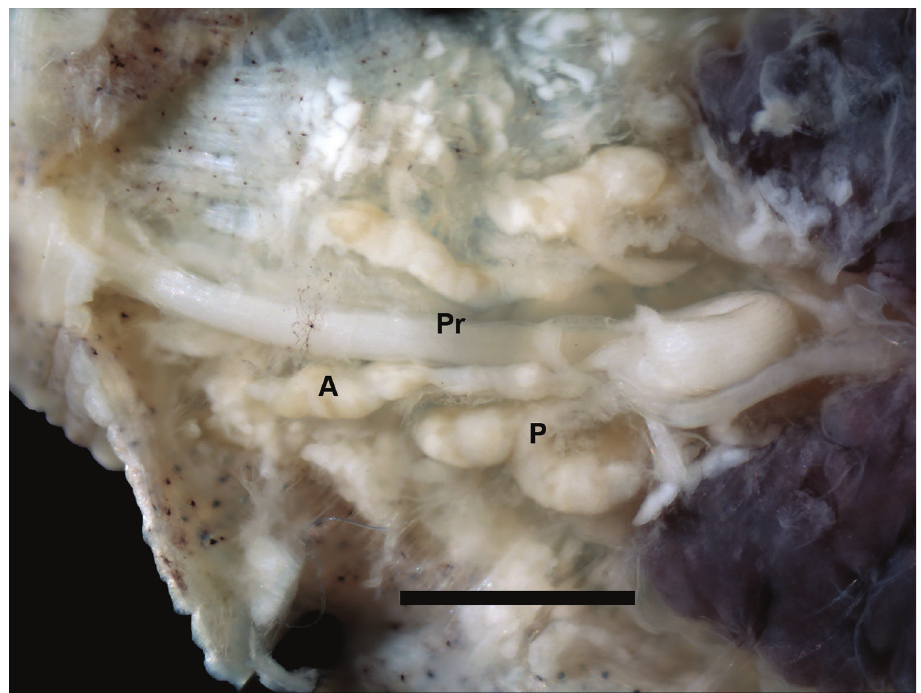
Figure 2. Internal anatomy of Placobdella siddalli Richardson & Moser, YPM IZ 083875. Dorsal view, anterior salivary gland ( A ), posterior salivary gland ( P ), proboscis ( Pr ). Scale bar: 1 mm.